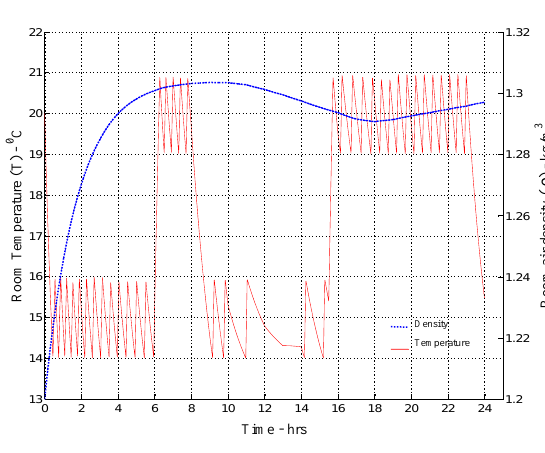
Figure 5: Temperature and density variations inside the building unit with On/Off control during this period, and no heat radiation is available from the occupants. As mentioned in the previous case, solar irradiation lessens the need to have the heater on during the day, which is true for this case too.